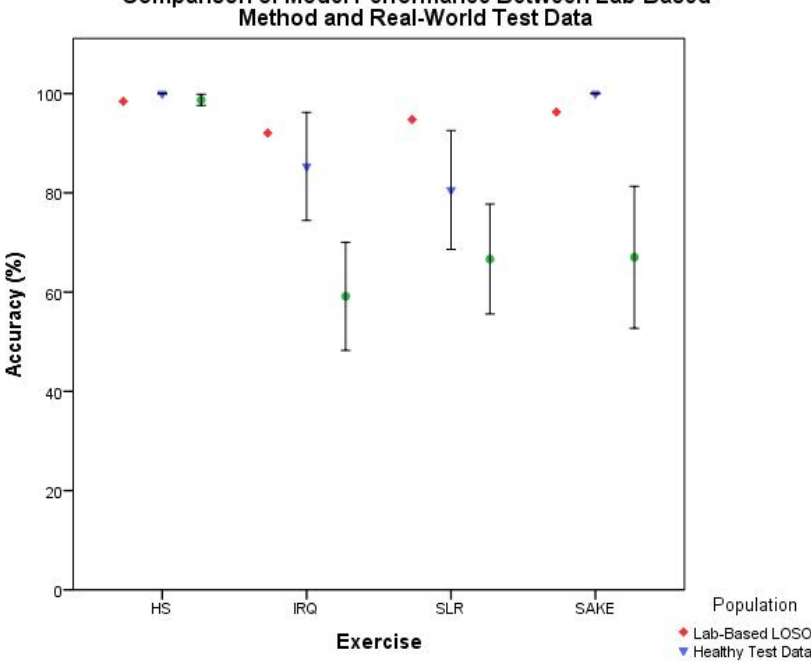
Figure 9. Comparison of overall biofeedback model performance between lab-based cross-validation, and healthy and clinical test data.